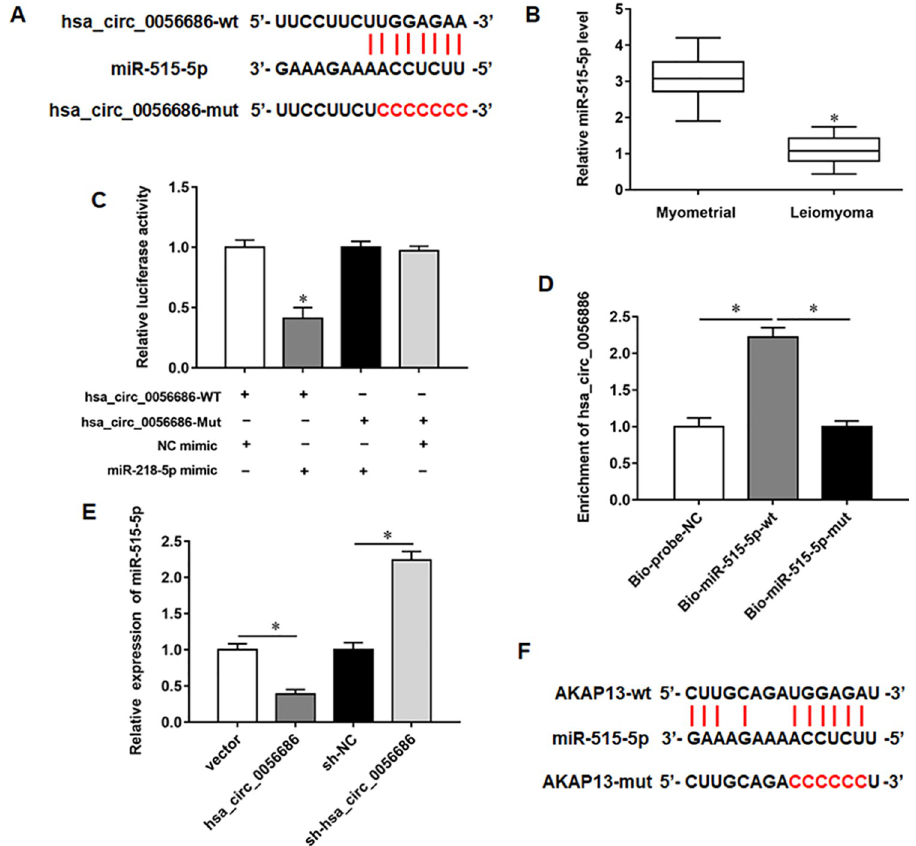
Fig 6. MiR-515-5p was a direct target of hsa_circ_0056686. (A) The sequences of hsa_circ_0056686 containing the miR-515-5p binding sites or mutant binding sites were showed. (B) (n = 30) Relative miR-515-5p expression level in ULM tissues and normal myometrial tissues. (C) The luciferase activity was tested after transfecting hsa_circ_0056686-wt and hsa_circ_0056686-mut. (D) RNA pull down assay was performed to detect the enrichment of hsa_circ_0056686 in the Bio-miR-515-5p-wt group and Bio-probe-NC group. (E) The expression of miR-515-5p was detected after overexpressing or silencing hsa_circ_0056686. (F) The sequences of miR-515-5p containing the AKAP13 binding sites or mutant binding sites were showed. � P < 0.05, vs normal myometrial tissues (B), NC mimic (C), Bio-probe-NC (D), vector or sh-NC (E).